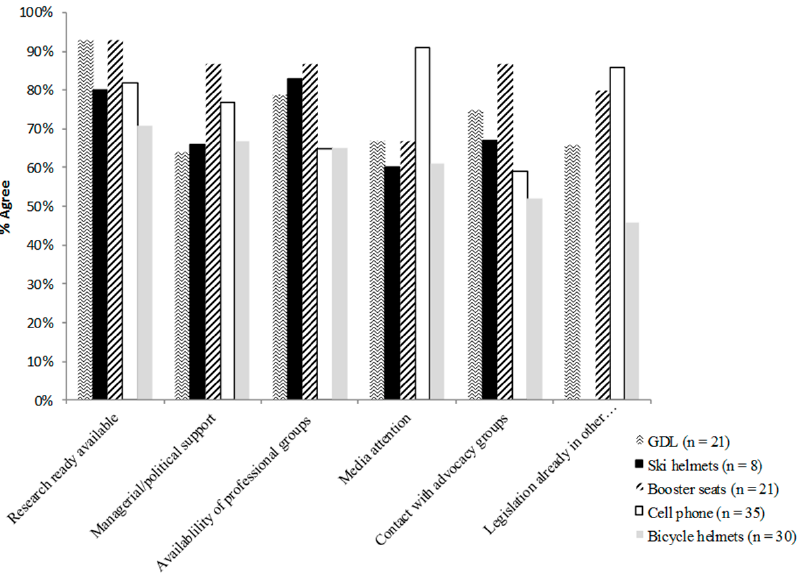
Figure 5. Legislation for (topic) __ as it currently stands has been instituted in my province because… * ( * Somewhat/strongly agree have been summed together for clarity ) .